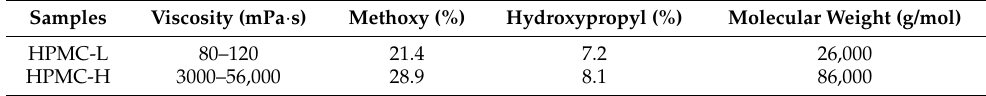
Table 1. Properties of the HPMC used, as provided by the